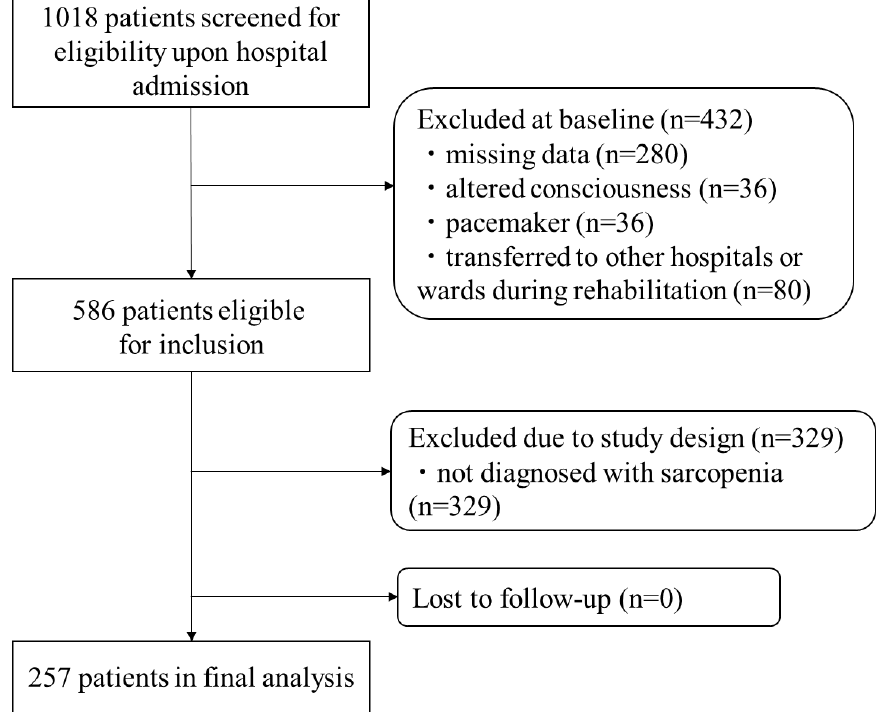
Figure 1. A flowchart of participant screening, inclusion, exclusion, and follow-up.